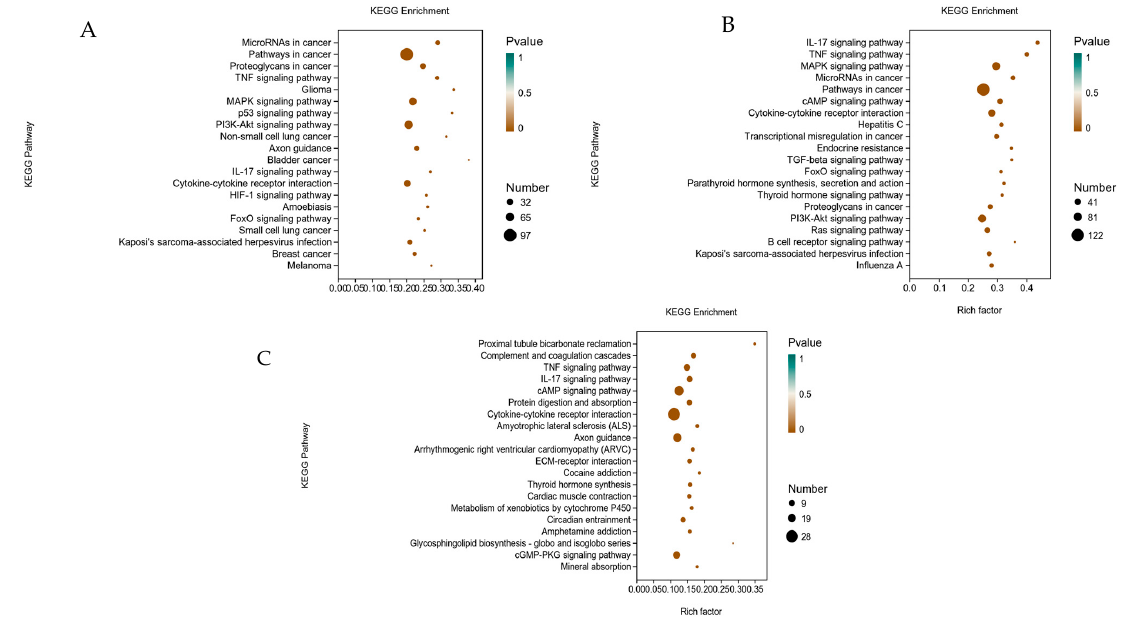
Figure 4. Enrichment analysis diagram of KEGG in H 2 O 2 -stimulated IEC-6 cells. ( A ) Control group, ( B ) Model group. ( C ) CYP group. The top 20 classical pathways obtained through KEGG enrichment are shown in the figure.